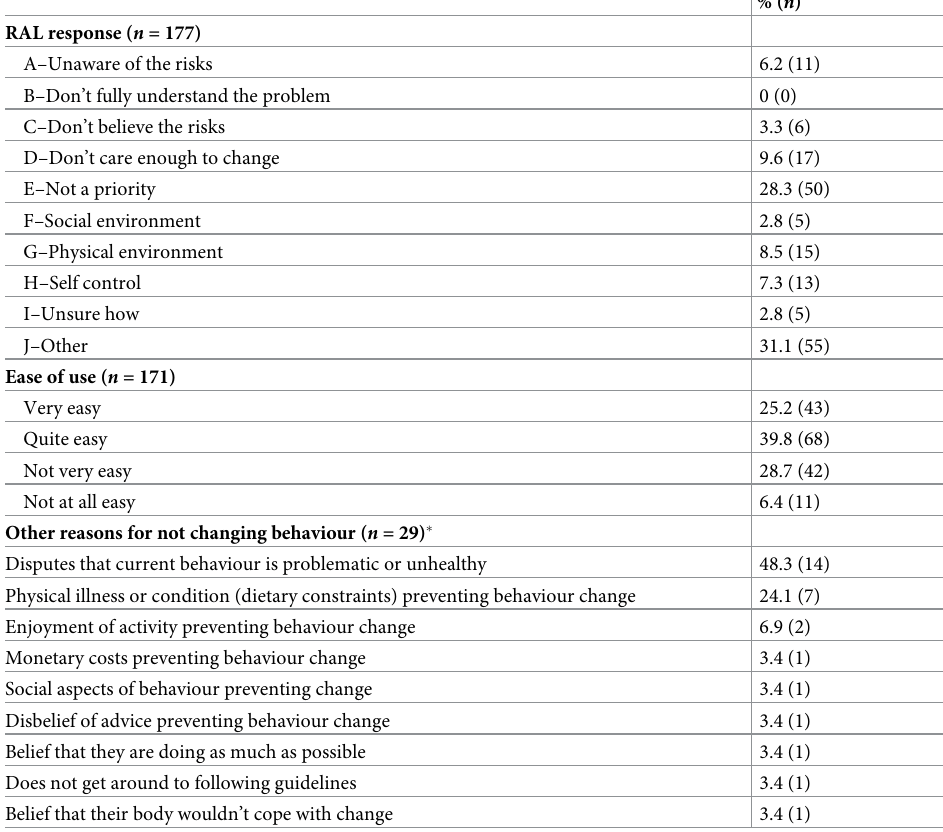
Table 3. Distribution of RAL responses, ease of use and reasons for selecting the ‘Other’ response